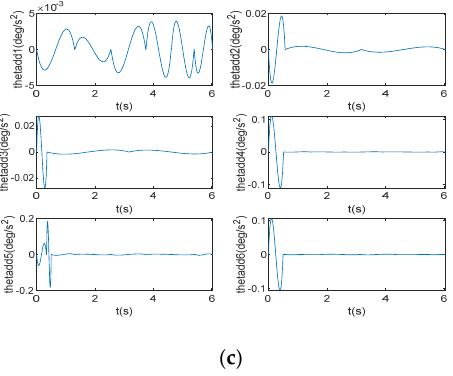
Figure 12. Joint space curve under NURBS planning; (a)Angle curves of six joints under NURBS planning; (b)Angular velocity curves of six joints under NURBS planning; (c)Angular acceleration curves of six joints under NURBS planning.